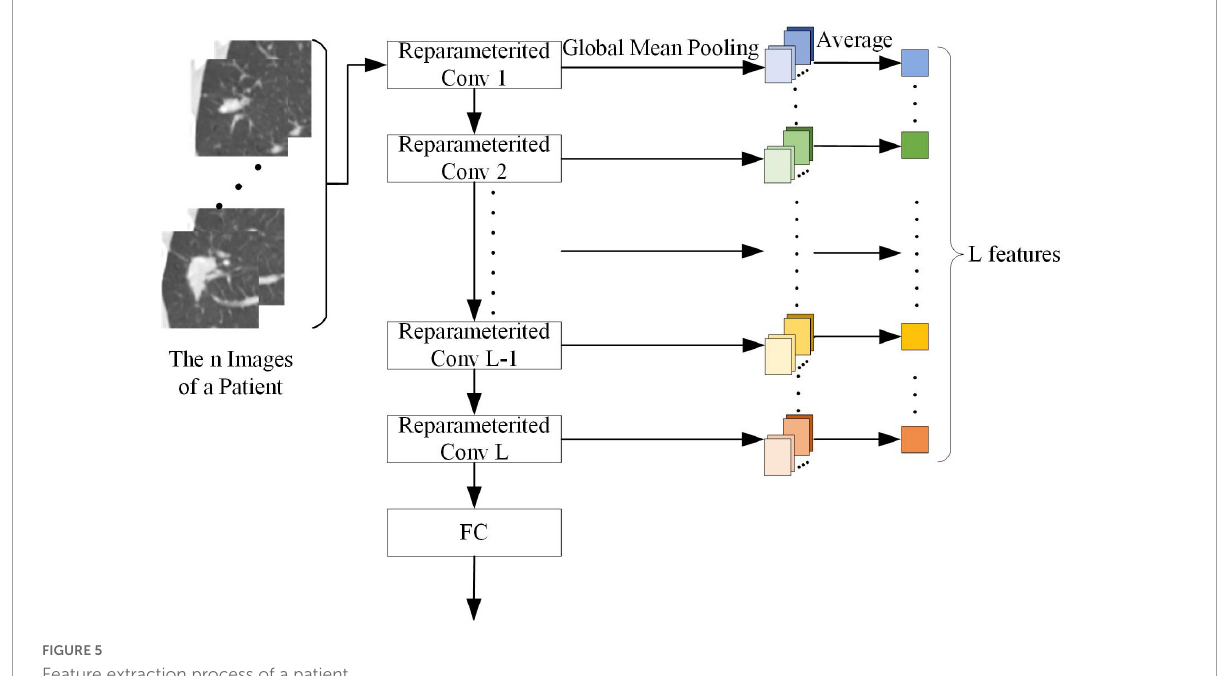
FIGURE5 Feature extraction process of a patient.